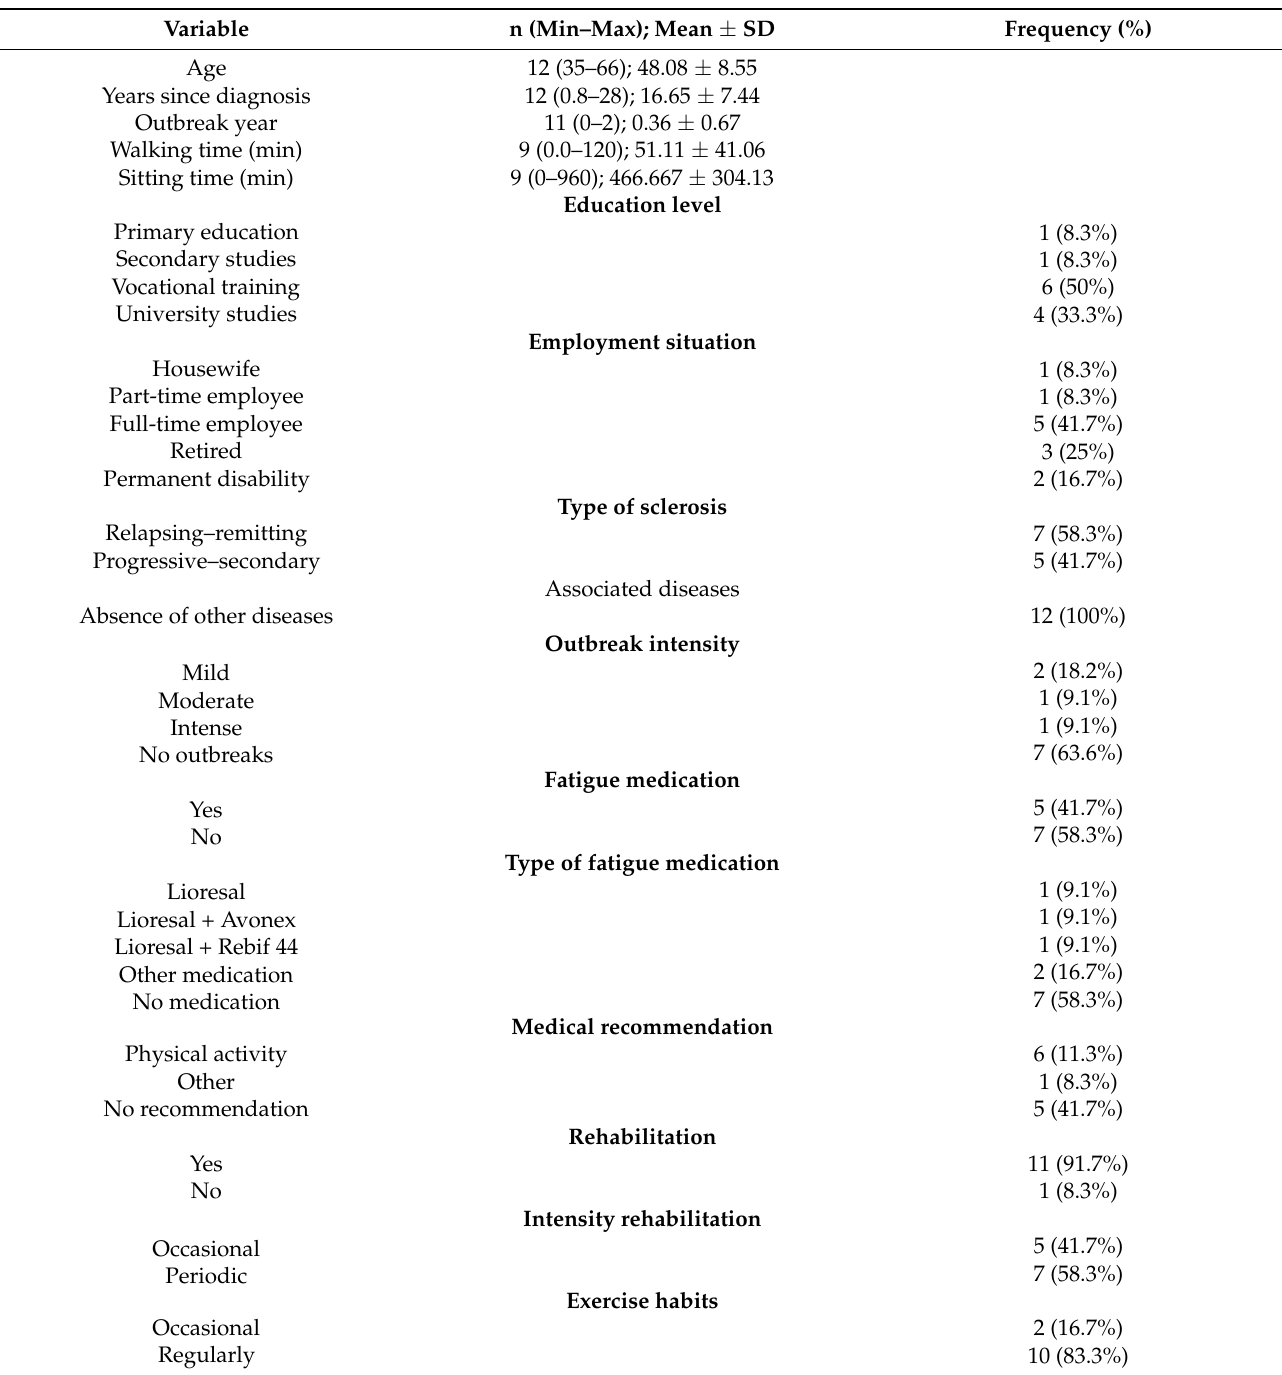
Table 2. Participants’ baseline demographic and clinical